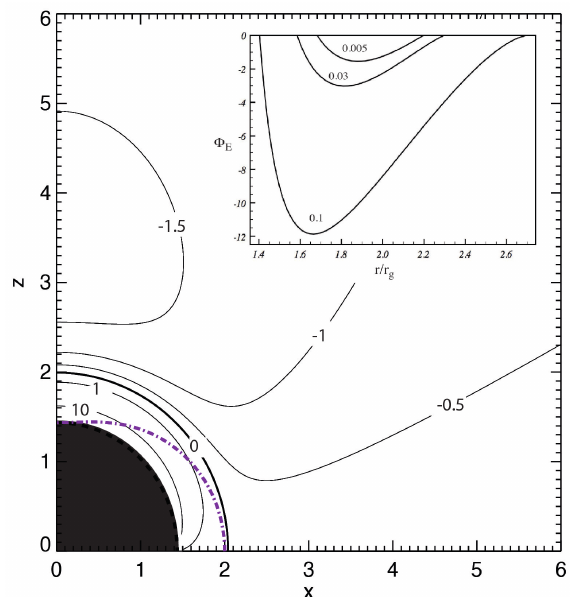
Figure 7. Contours of ρ GJ for a split monopole geometry with a / M = 0.9, Ω = 0.5 ω H . The numbers that label the curves are values of ρ GJ ( r , θ ) , normalized by aB H /2 π , where B H = Ψ H / strength of the magnetic field on the horizon. The thick solid line corresponds to the null surface on which ρ GJ = 0. The black circle delineates the interior of the black hole, and the purple dashed-dotted line marks the static surface. The inset shows solutions for the electric flux, Φ E = Equation (4) with ρ e << ρ GJ along a magnetic surface inclined at θ = 30 ◦ , in a magnetosphere of a supermassive black hole of mass M = 10 9 M (cid:12) , for B H = 10 4